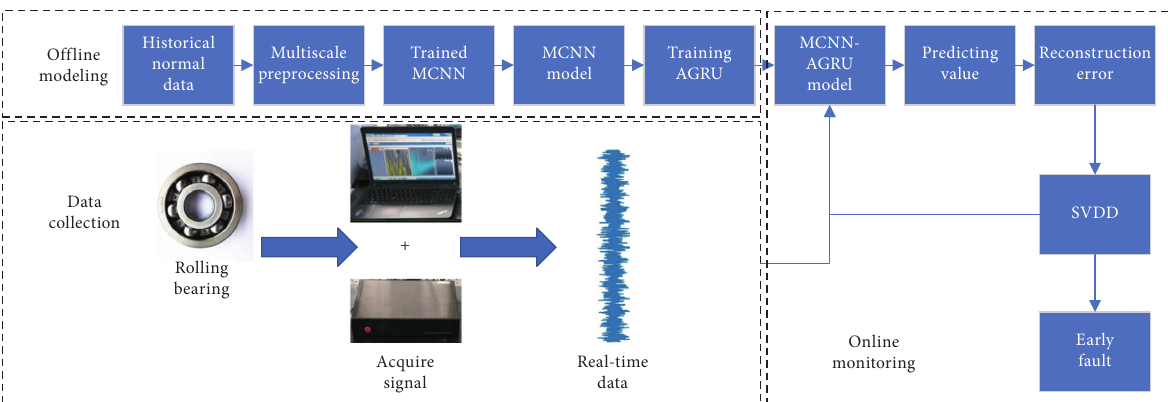
Figure 8: MCNN-AGRU early failure detection